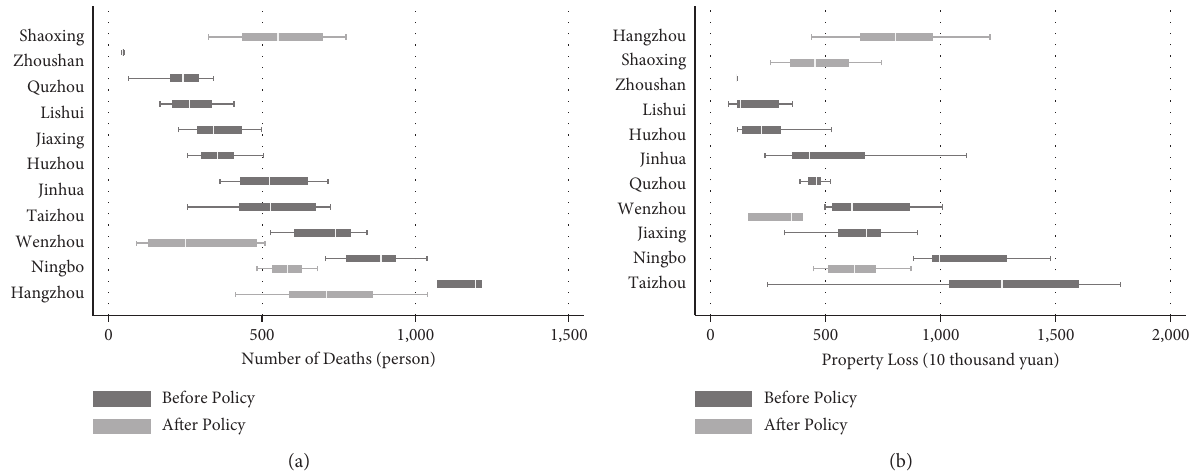
Figure 6: Comparison of the death number and property loss before and after the motorcycle bans in 11 cities in Zhejiang Province (2002–2019). (a) Number of deaths. (b) Property